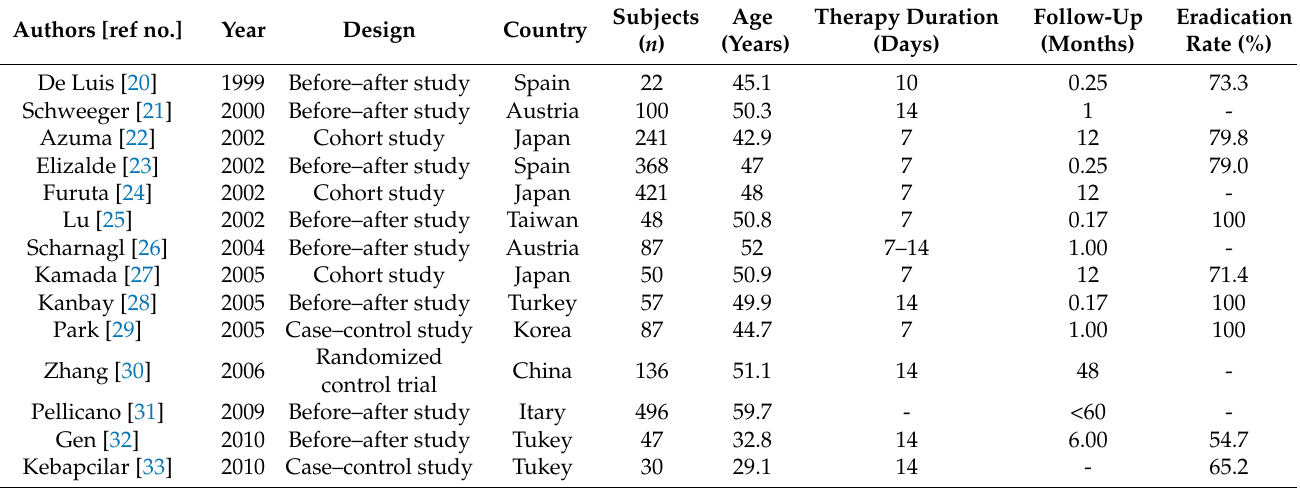
Table 1. Summary of the characteristics of the included